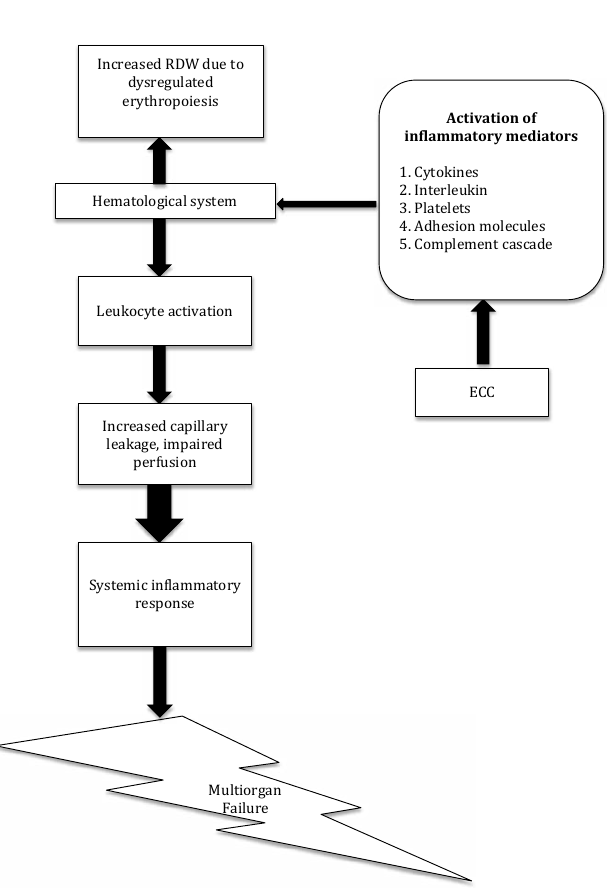
Fig. 3 - Proposed hypothesis for correlation between high red cell distribution width and